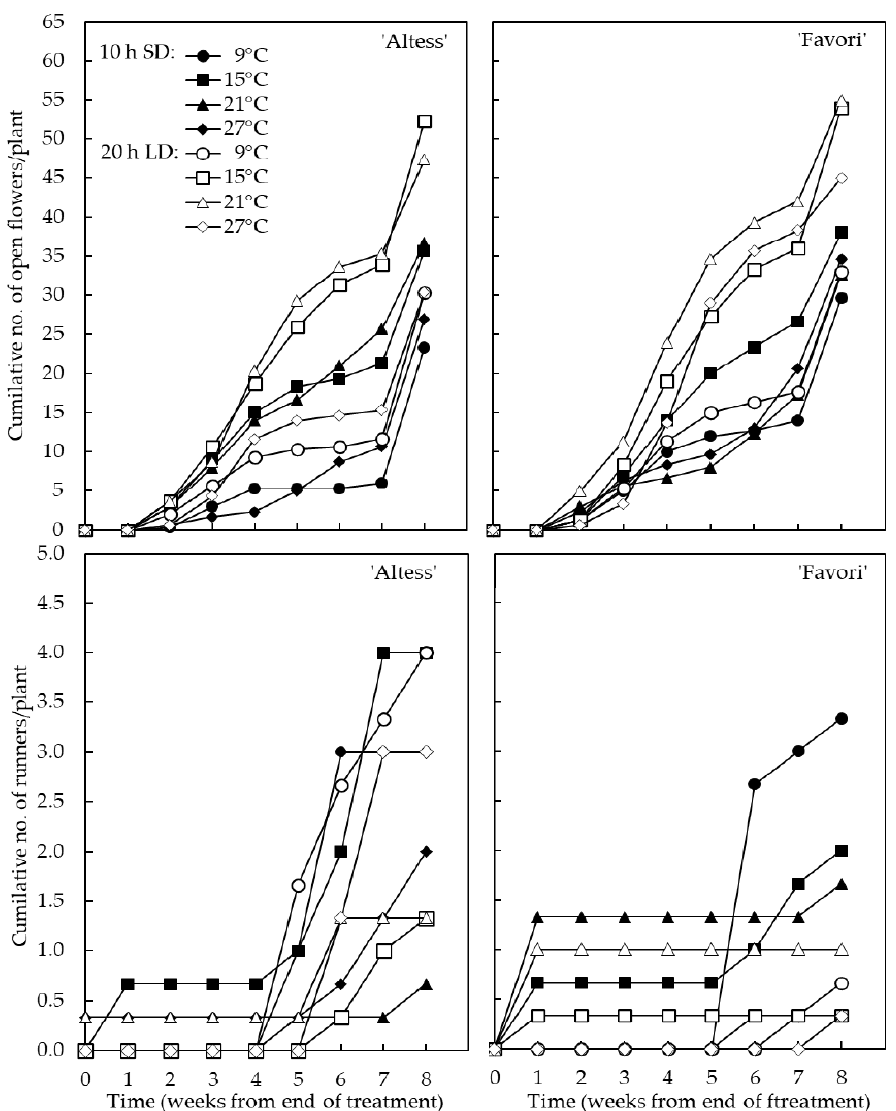
Figure 4. Time courses of cumulative flower (top panel) and runner formation in two EB strawberry cultivars as affected by 4 weeks of temperature and photoperiod pre-conditioning as indicated, followed by further raising under natural outdoor conditions from 12 September until 24 October. The plants were forced for 8 weeks in a greenhouse in 20-h LD at 20 ◦ C. The data are means of three replicates, each with one plant of each cultivar.